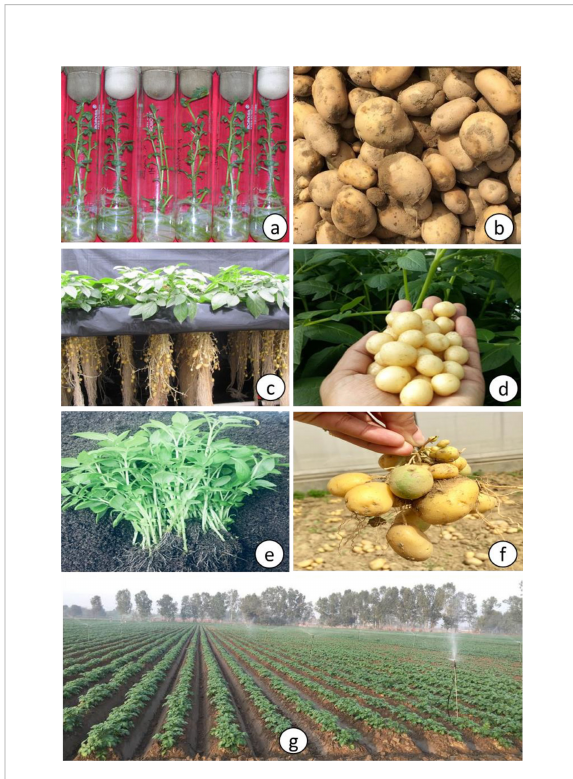
FIGURE 1 Recent innovations in Tissue Culture based seed potato system. (A) Healthy microplants. (B) Minitubers directly produced from microplants. (C) minitubers developed in aeroponic chamber. (D) Harvested minitubers. (E) Apical rooted cuttings ready for transplanting (F) Apical rooted cuttings raised tubers. And (G) Minituber crop in the fi